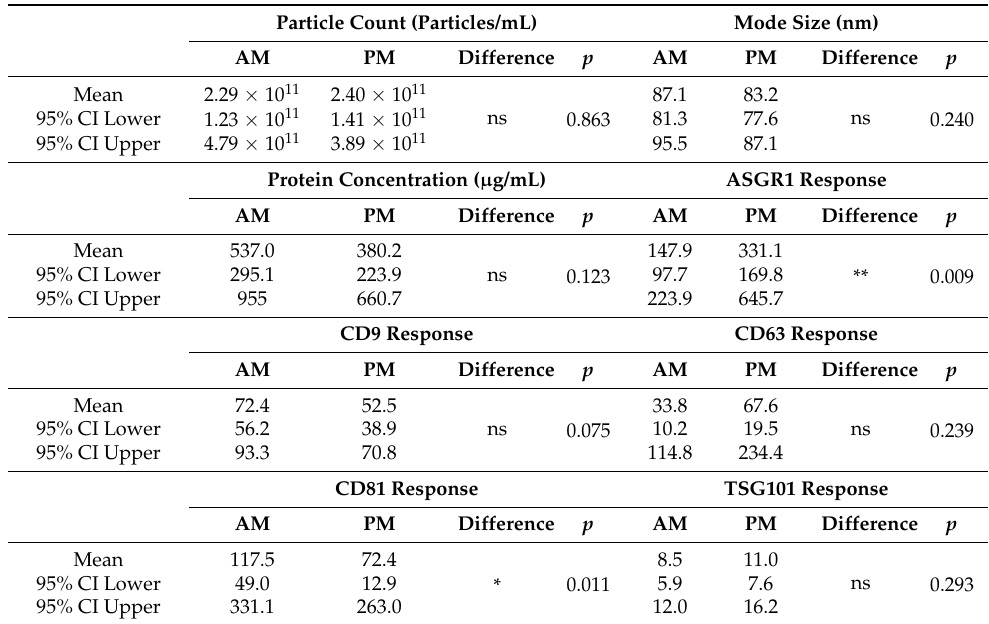
Figure 5. Diurnal variability of serum EV particle abundance ( A ), size ( B ), total protein concentration ( C ) and expression of EV-associated protein markers ( D – H ), quantified by nanoparticle tracking analysis (NTA), microBCA assay and liquid chromatography mass spectrometry (LCMS) in the morning (AM) and afternoon (PM) on study days 1 and 3 in healthy volunteers ( n = 20). Statistical analysis performed using paired t-tests. * p ≤ 0.05, ** p ≤ 0.01. Table 4. Pooled analysis of EVs collected from serum of healthy volunteers on study days 1 and 3 ( n = 20) for comparison of morning and afternoon. Data presented as geometric mean and 95% confidence interval (CI) of particle count, mode size, total protein concentration, and EV-associated protein marker abundance. Statistical analysis performed using paired t -tests. ns: not significant, * p ≤ 0.05, ** p ≤